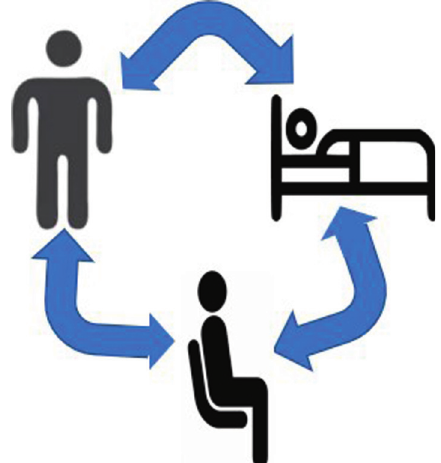
Figure 1: The type of activities in HAPT data.